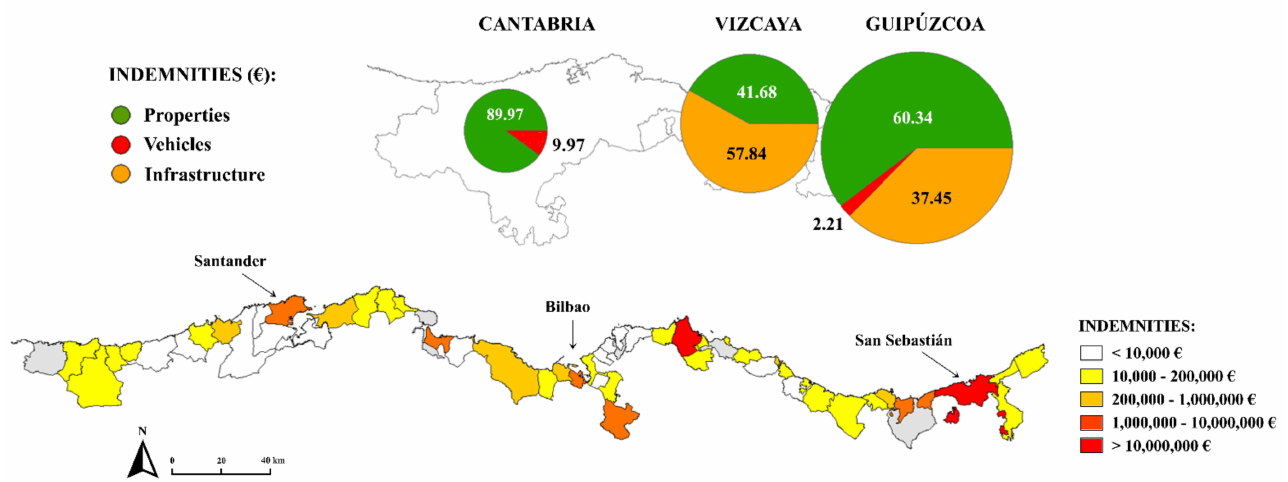
Figure 8. Spatial distribution of